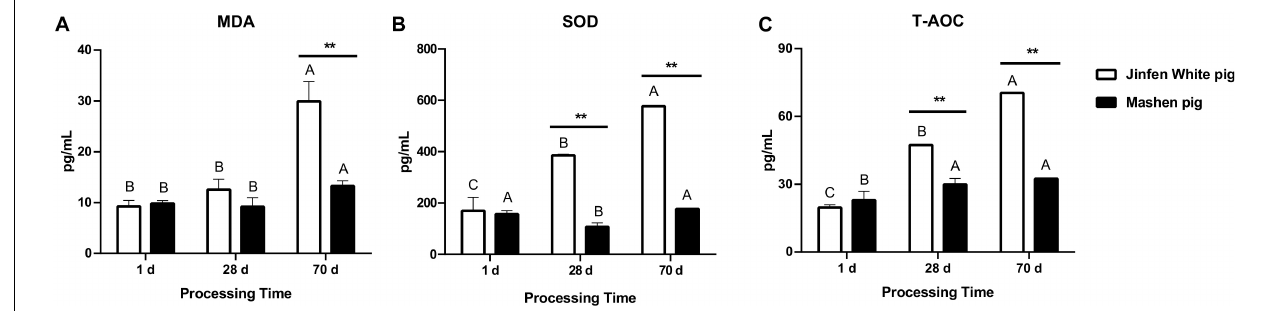
FIGURE 2 | The change of antioxidant index in serum. (A) The content of MDA, (B) SOD, and (C) T-AOC in serum of Jinfen White and Mashen piglets. * P < 0.05, ** P < 0.01, and *** P < 0.001 indicate significant difference between two pig breeds.